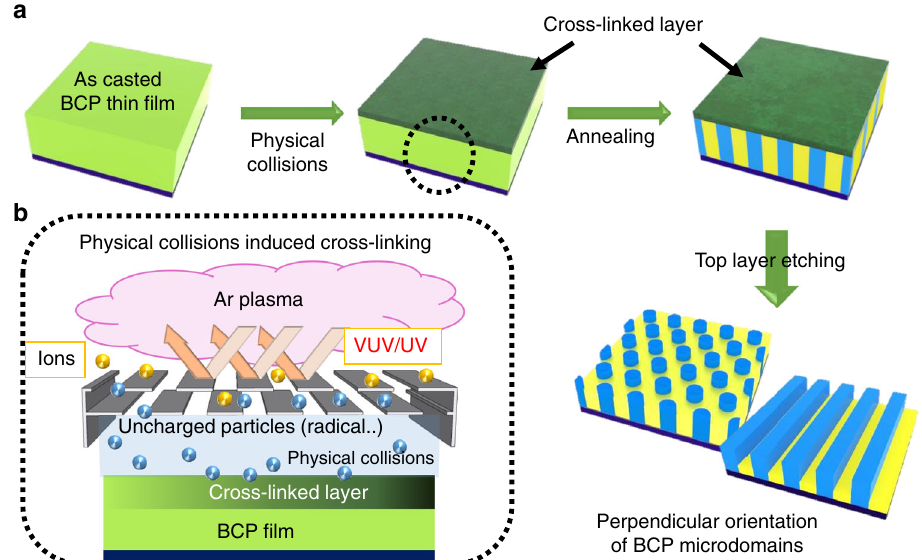
Fig. 1 Filtered plasma treatment to form the cross-linked layer for perpendicular orientation of BCP microdomains. Schematics of a the plasma assisted process and b the fi lter which blocks ion bombardment and VUV/UV generated by the argon plasma. Only the Ar neutral particles impinge obliquely on the surface of the fi lm, forming a thin cross-linked layer without composition changes or etching. The cross-linked layer exhibits a neutral surface af fi nity for the BCPs, so that the perpendicular orientation of the BCP microdomains in the fi lm after annealing can be induced regardless of the type, molecular weight, or fraction of the BCP